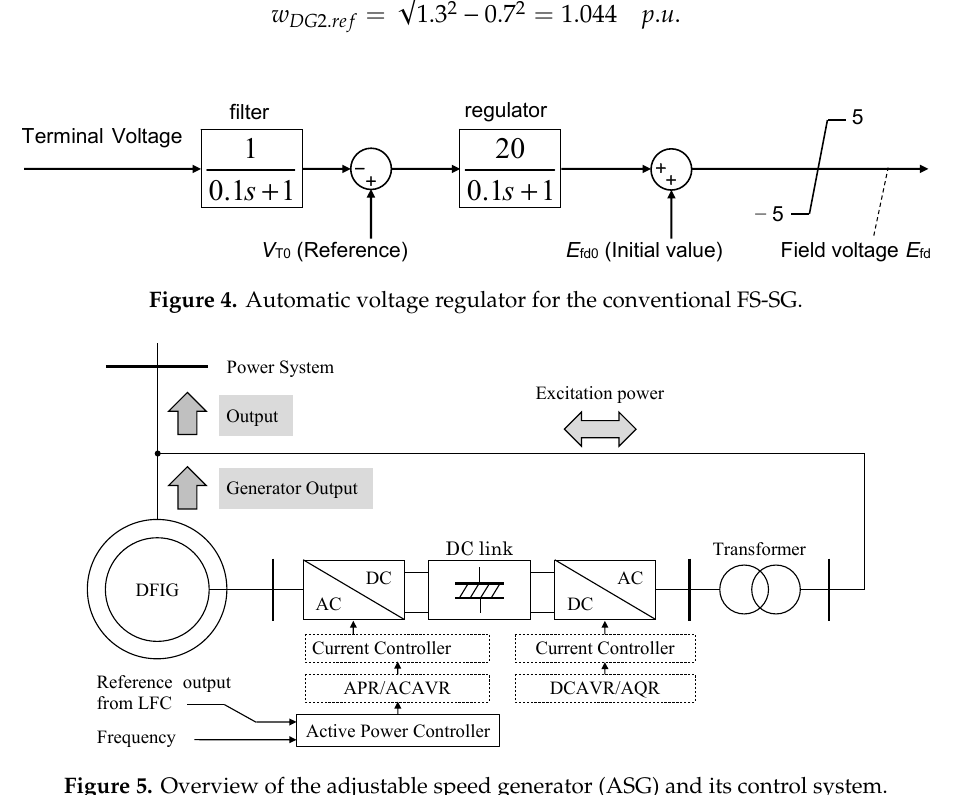
Figure 3. Model of a load frequency control (LFC).